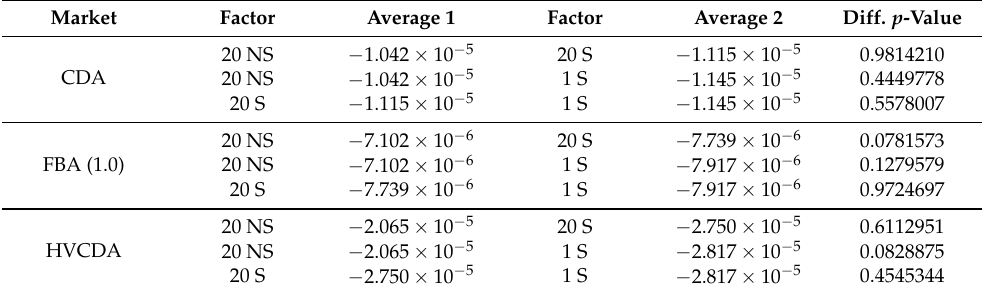
Table 9. Tukey’s HSD test applied to the stress traders factor, filtered by the market type factor.